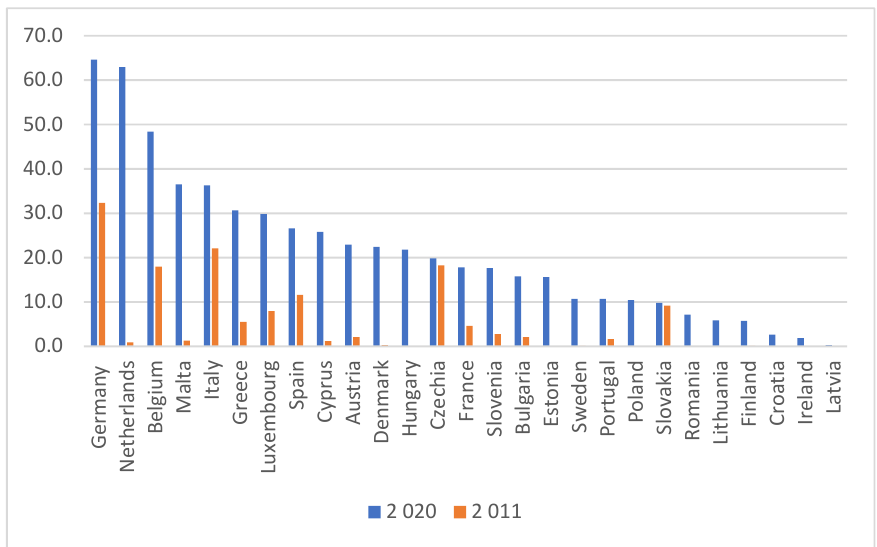
Figure 4. Energy production from renewable sources (solar energy in megawatts per 100.000 popu- lation).